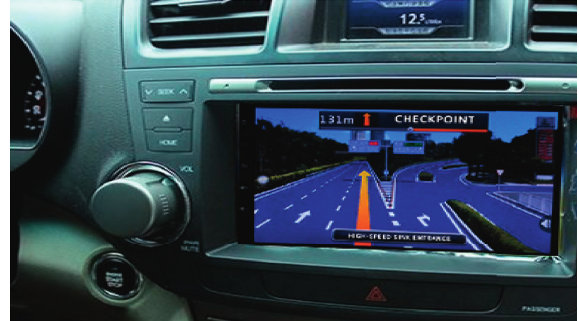
Figure 8: Multimedia communication system road traffic sign prompt.